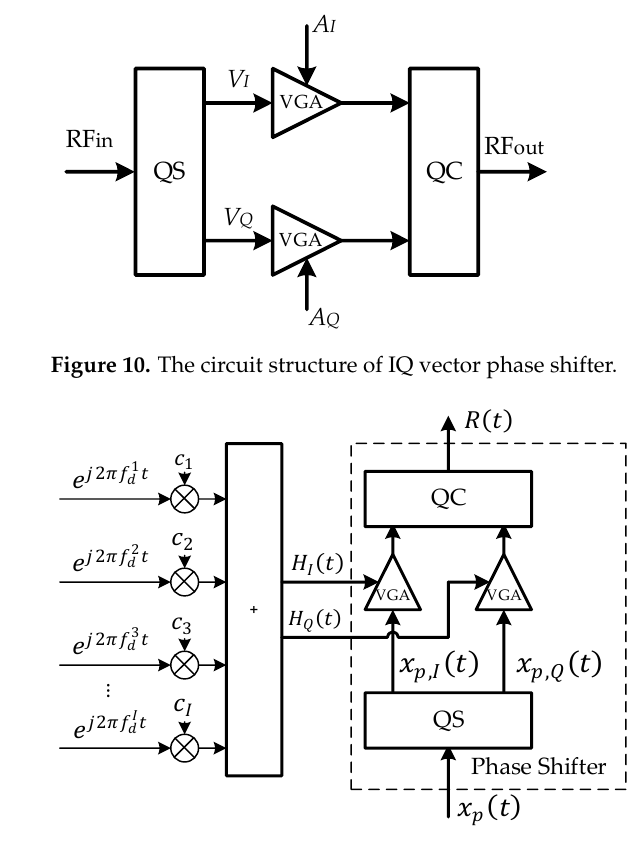
Figure 11. Physical simulation model of the channel.